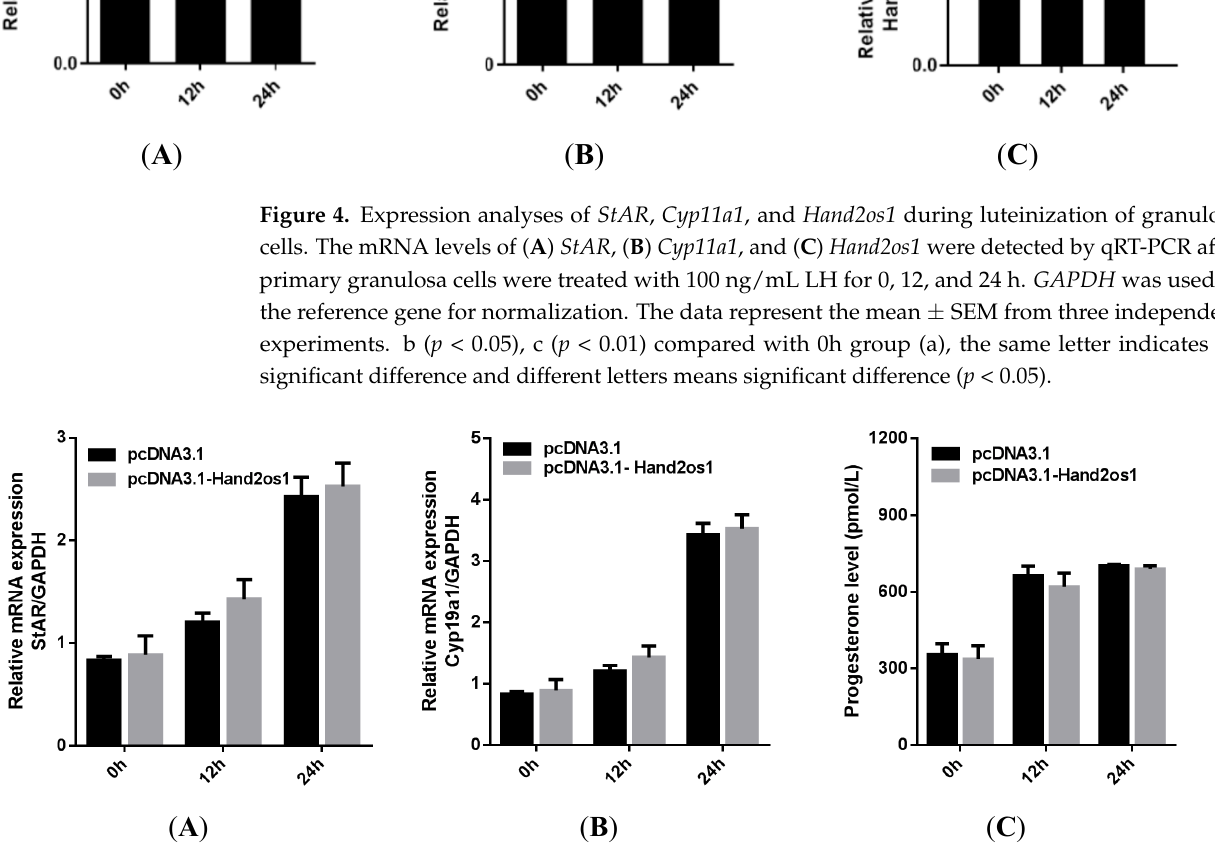
Figure 5. Effects of Hand2os1 on the expression of steroidogenic enzymes and progesterone production in LH-induced luteinized granulosa cells. The mRNA levels of ( A ) StAR and ( B ) Cyp11a1 were detected by qRT-PCR in 1 IU/mL LH-treated granulosa cells after transfection with pcDNA3.1-Hand2os1 for 0, 12, and 24 h. ( C ) Meanwhile, the concentration of progesterone in the culture supernatants were determined by ELISA. GAPDH was used as the reference gene for normalization. The data represent the mean ± SEM from three independent experiments.